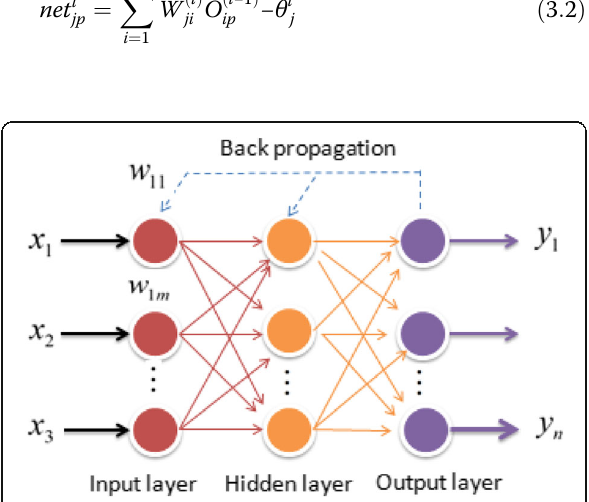
Fig. 4 Forward network